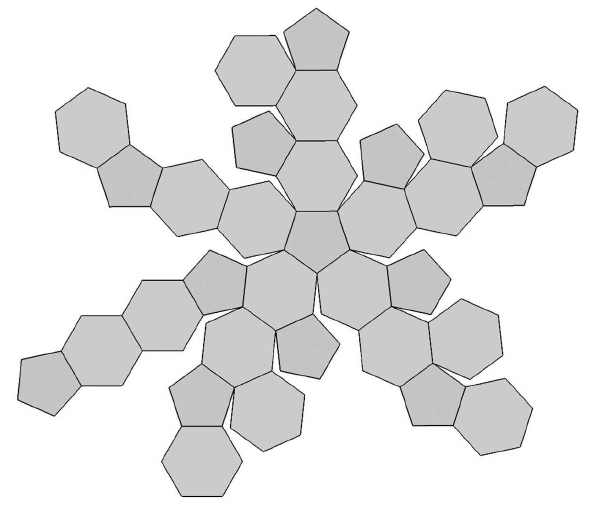
Figure 12. Development of the truncated icosahedron.